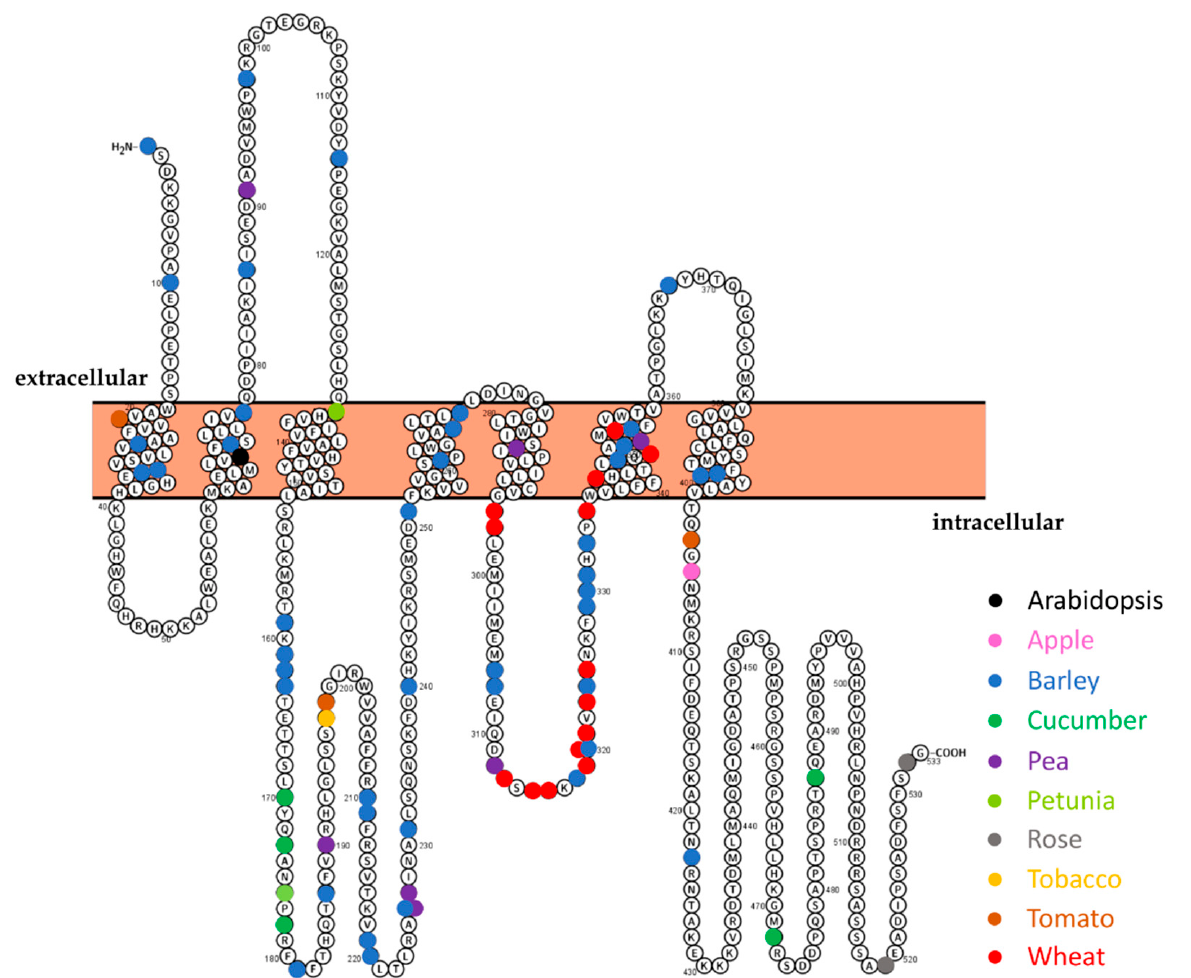
Figure 5. Schematic representation of the complete barley HvMLO protein. The orange bar represents the plant membrane. Colored dots indicate the amino acids of the corresponding mlo -mutants in different plant species. Overview of the depicted mlo -mutants are shown in Table S4.